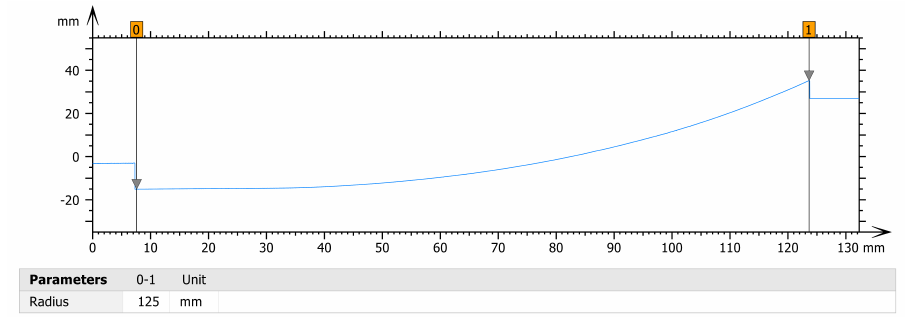
Figure 8. Sample #160 snap through profile taken with the Nanovea